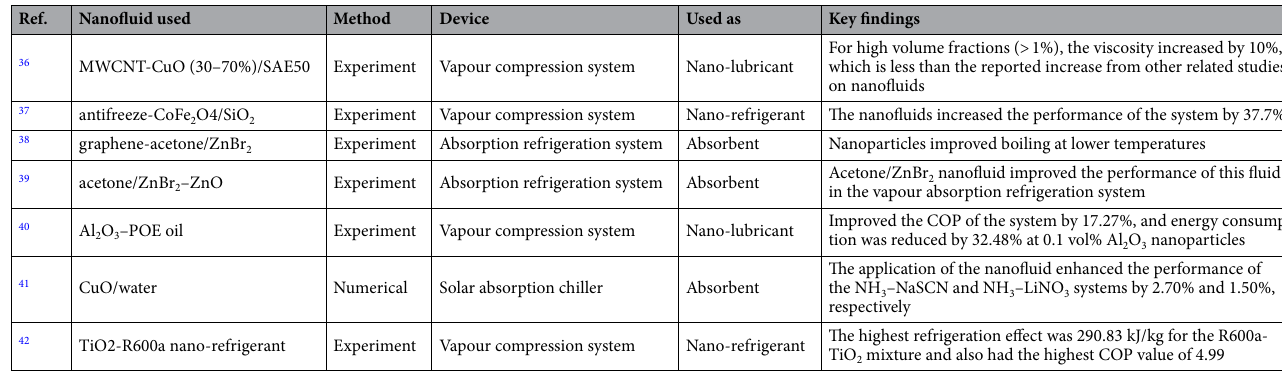
Table 1. Studies related to the application of nanofluids in cooling